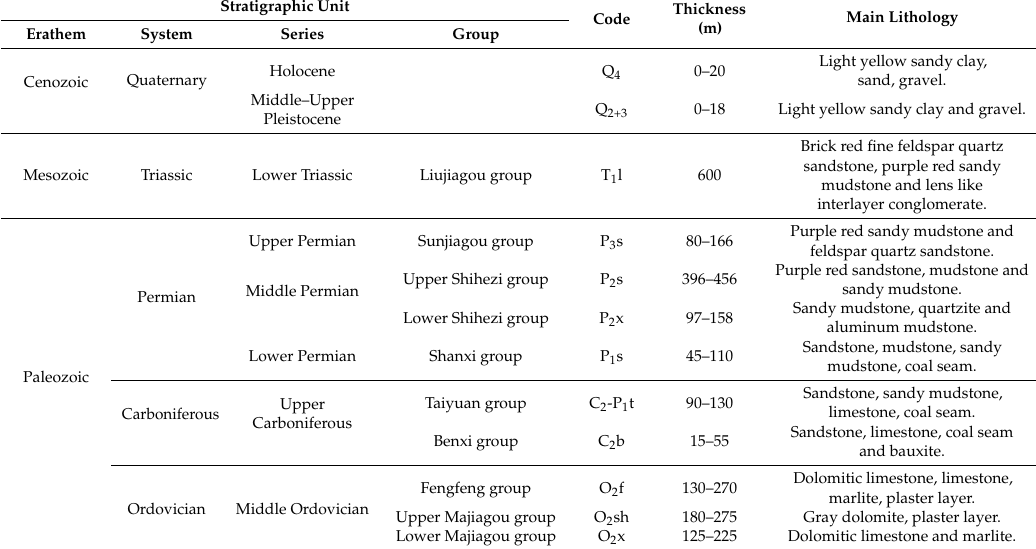
Table 1. Regional stratigraphic